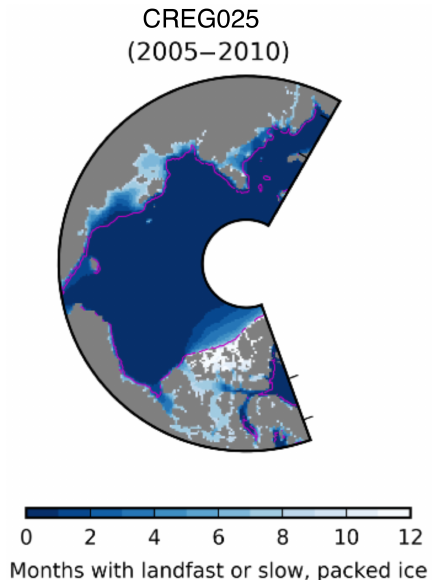
Figure 10. Same as Fig. 2b but for the CREG025